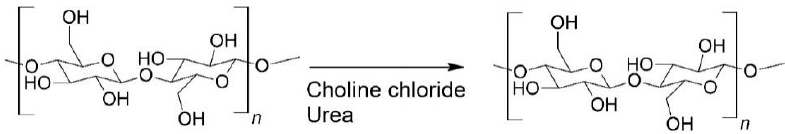
Figure 2. Non-derivative pre-treatment of cellulose with urea-choline chloride DES.